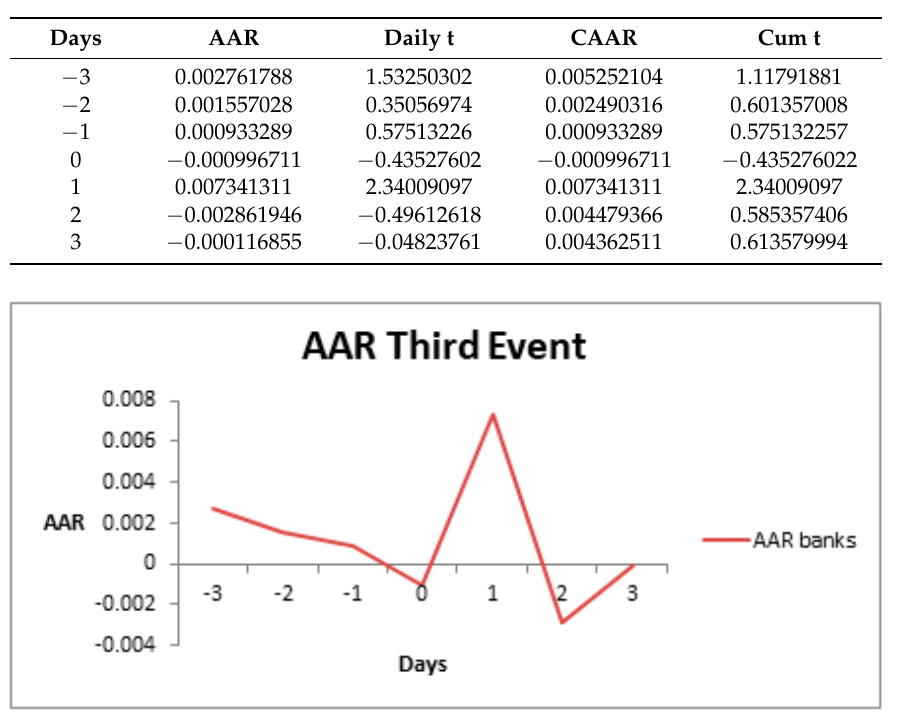
Figure 6. Average Abnormal Return (AAR) for banks. Source: Authors’ work.